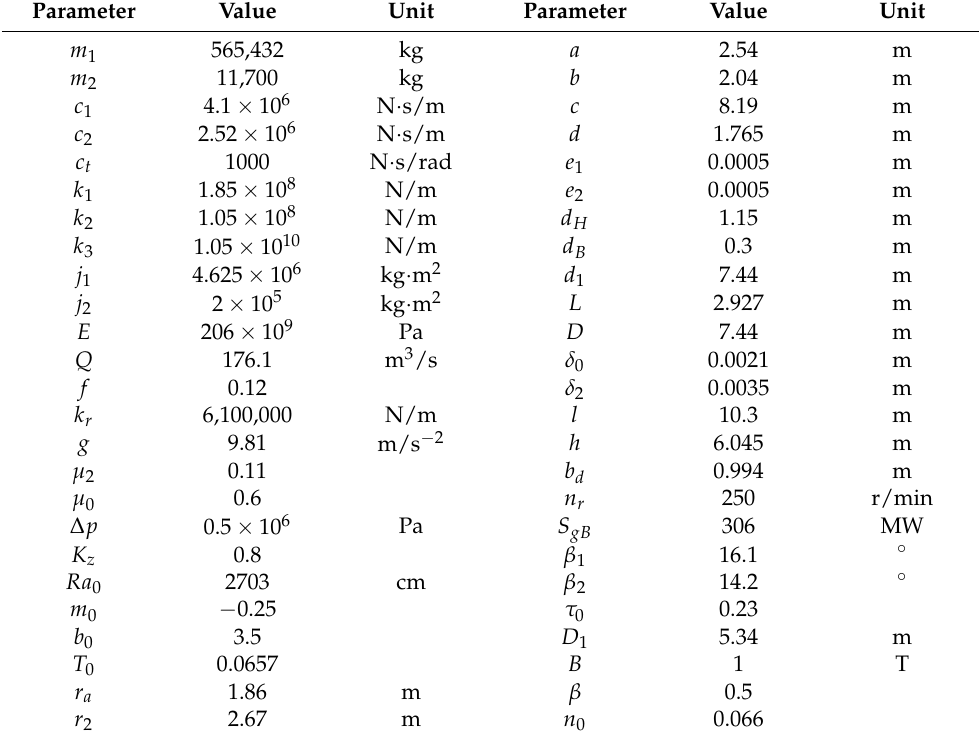
Table 1. Actual design parameters of a hydropower